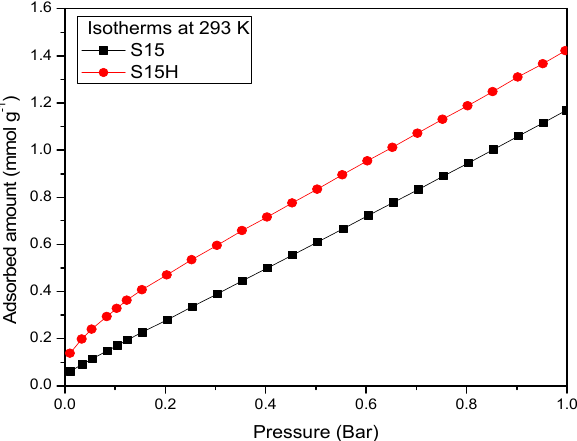
Figure 14. CO 2 adsorption at 293 K, on SBA-15 precursor (S15) samples and hydroxylated (S15H) samples.